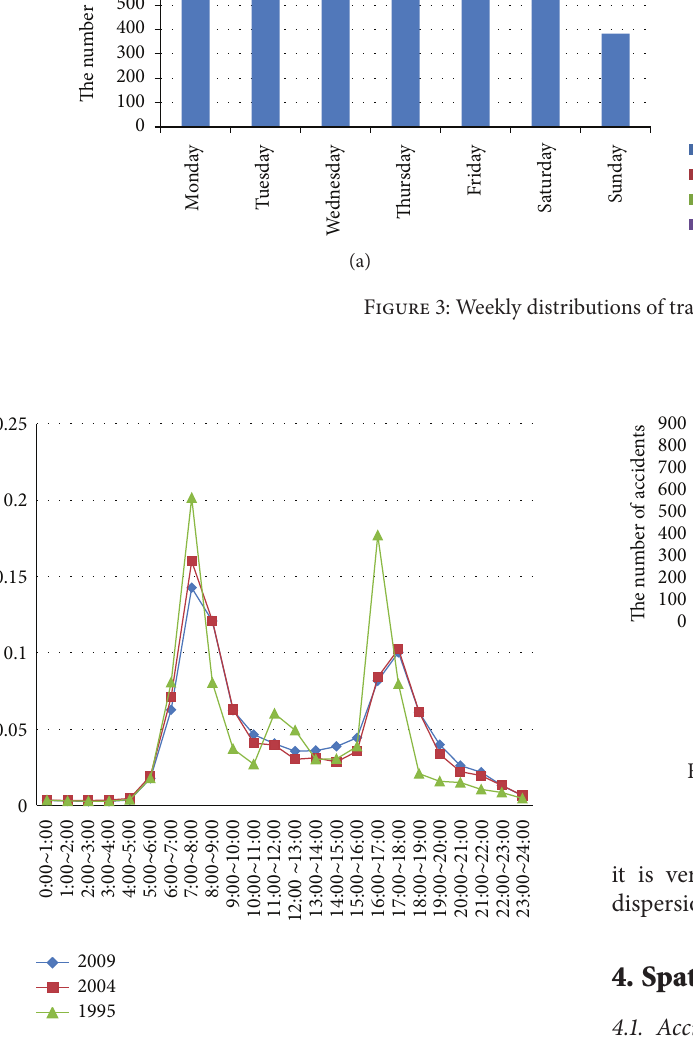
Figure 4: Hourly profiles of trips.